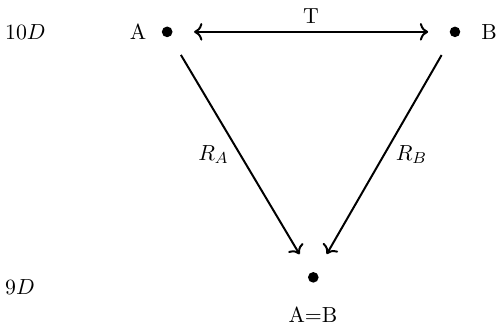
Figure 1 . T-duality provides a map between two supergravity theories A and B, each supplemented with a spatial isometry direction. The respective compact directions have a circumference R A = R and R B = ‘ 2 /R , respectively. In this target space approach T-duality means that both theories s A/B reduce to the same theory in nine dimensions. The T-duality rules are then effectively obtained by reducing theory A to nine dimensions and uplifting the result to theory B (or vice